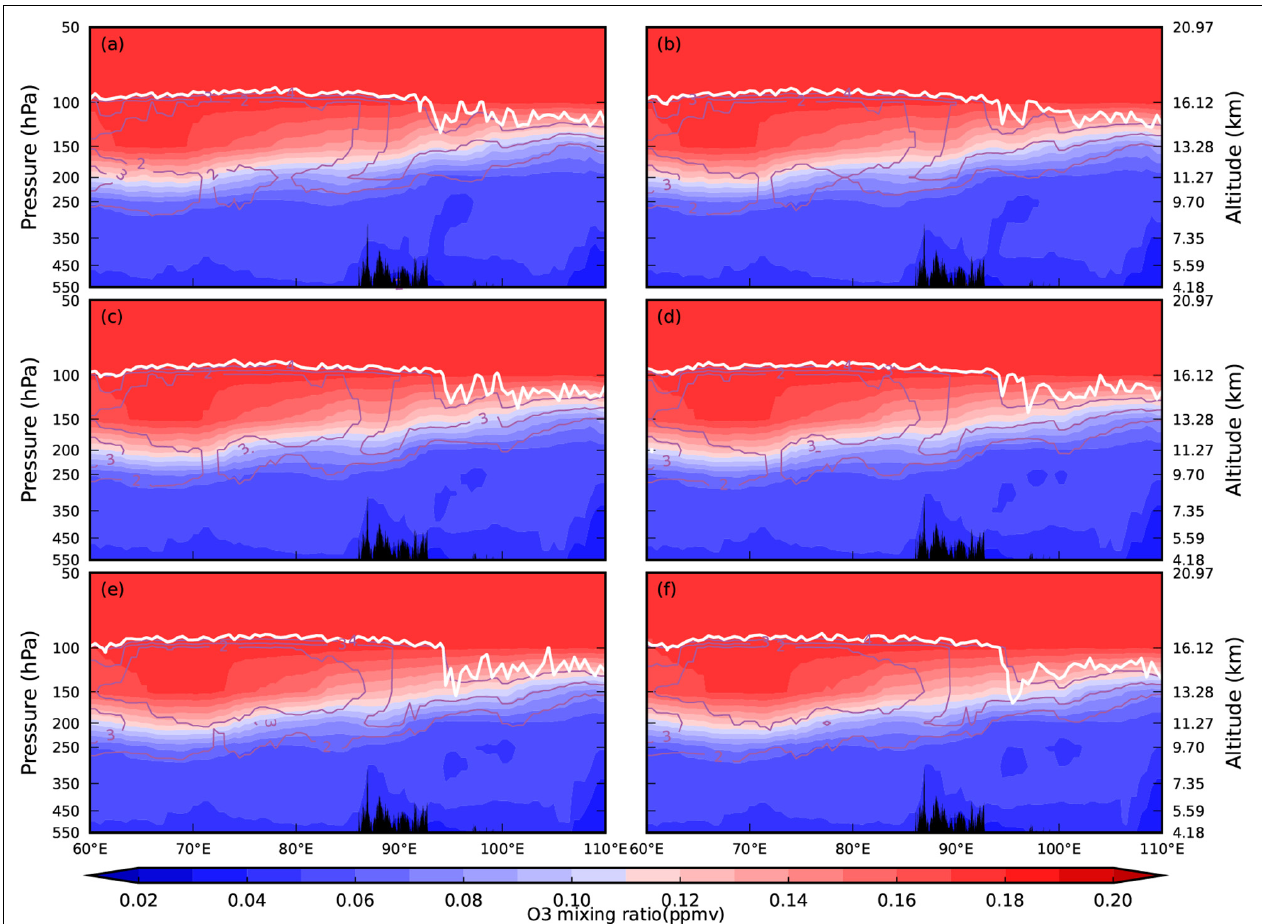
FIGURE 11 | Longitude–height cross section of the ozone mixing ratio (unit: ppmv) along 28 ◦ N simulated by WRF on 3 May, 2014. The solid white lines indicate the thermal tropopause and the solid purple lines indicate potential vorticity (unit: PVU). Times shown are (a) 18:20; (b) 19:20; (c) 20:20; (d) 21:20; (e) 22:20; and (f)